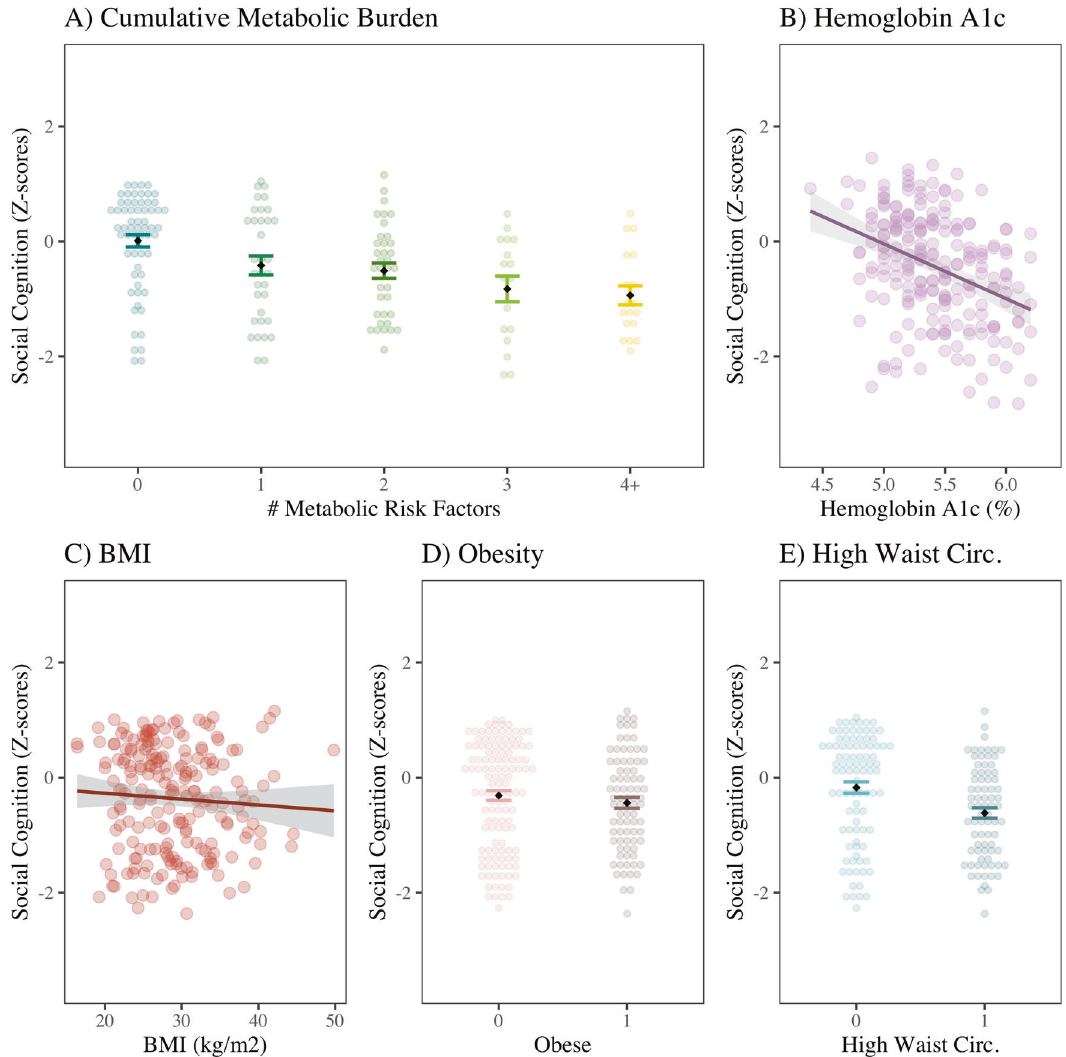
Fig. 1 Social Cognition and Metabolic Risk in SSD. A Cumulative metabolic burden included the following: obesity, high waist circumference, prediabetic HbA1c, diagnosis or medication for DM, diagnosis or medication for hypertension, and diagnosis or medication for hyperlipidemia; on a linear regression, there was a signi fi cant relationship between higher number of metabolic risk factors and greater impairment in social cognition ( β = − 0.38, p < 0.001, Adj R 2 = 0.14). B There was a signi fi cant negative relationship between overall social cognition and HbA1c ( β = − 0.37, p < 0.001, Adj R 2 = 0.14). There was no signi fi cant relationship between social cognition and ( C ) Body Mass Index ( β = − 0.05, p = 0.49) or ( D ) Obesity (Cohen ’ s d = 0.09, p = 0.34). E High waist circumference was signi fi cantly correlated with greater impairment in social cognition (Cohen ’ s d = 0.49, p = 0.002). However, only HbA1c remains signi fi cantly correlated with social cognition after covarying for age, sex, race, ethnicity, and non-social neurocognition ( β = − 0.16, p = 0.005, Adj R 2 = 0.53). Standardized β coef fi cients are